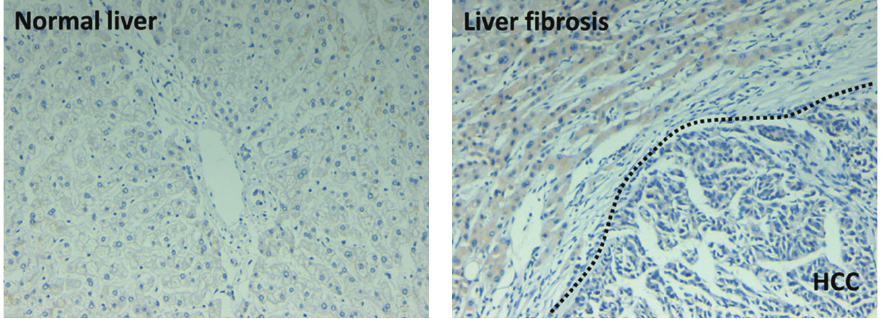
Figure 1: Expression of polo-like kinase 1 (PLK1) in hepatocellular carcinoma. Analysis of PLK1 expression in both normal liver and hepatocellular carcinoma (HCC) was performed by immunohistochemistry. Magnifications × 10 and magnification in insert ×